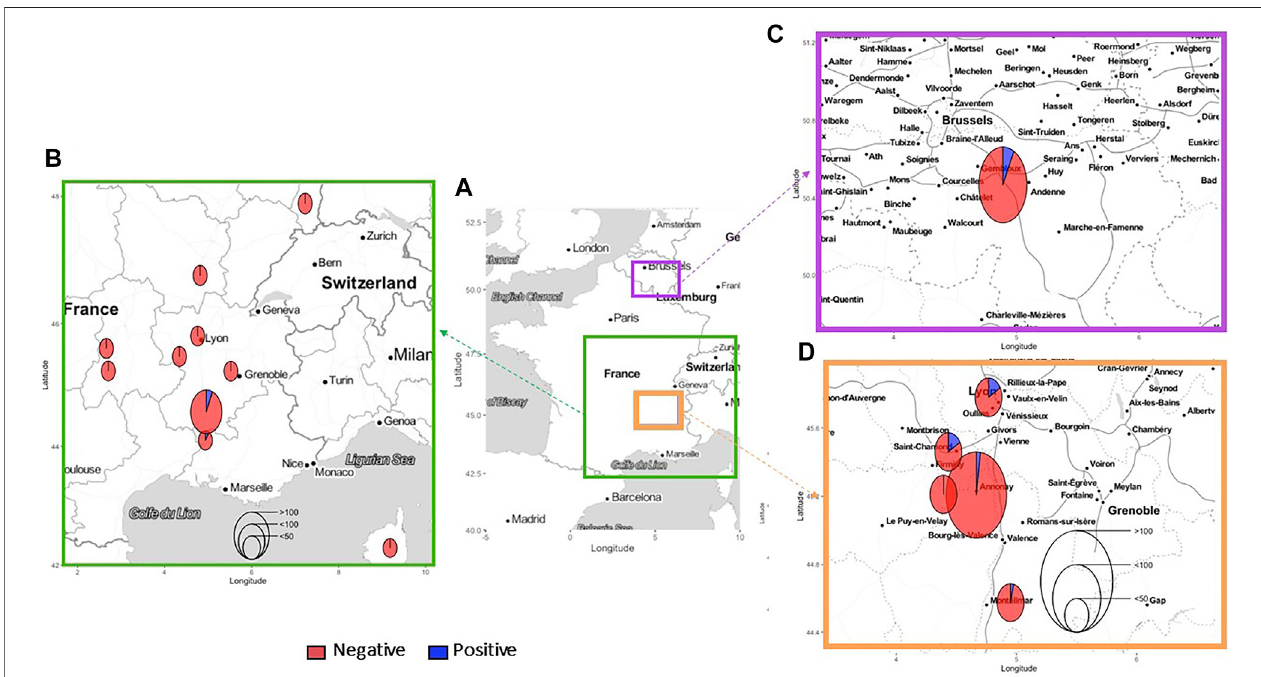
FIGURE 1 | Geographic areas of dog and cat feces samplings. In (A) Geographical areas in France and Belgium of dog (in green) and cat (in purple, Belgium; in orange, France) feces collections; In (B) zoom on the dog feces collection area. In (C) zoom on the cat feces collection area in Belgium. In (D) zoom on the cat feces collection area in France. The number of samples per site and the number of positives samples per site are represented by the size of the circle.